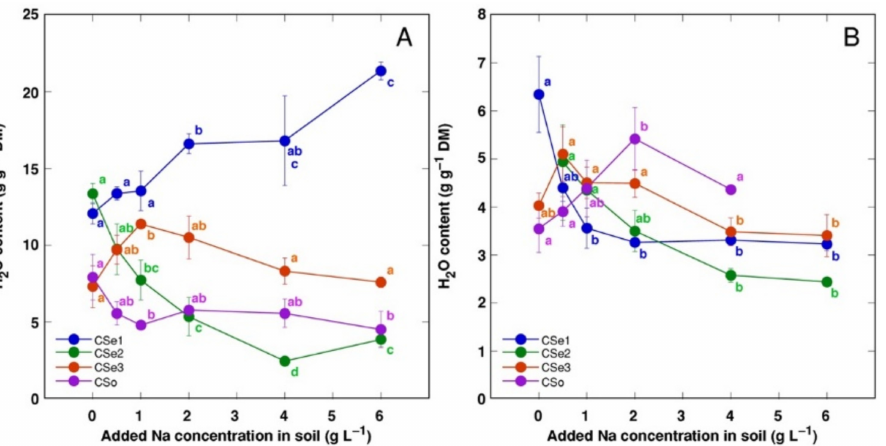
Figure 4. Effect of increasing soil salinity on water content in roots ( A ) and rhizomes ( B ) of Calystegia sepium accessions CSe1, CSe2, CSe3 and Calystegia soldanella (CSo). Na + was added in a form of NaCl. Data are means from five replicates for each concentration ± SE. Different letters of the respective color indicate statistically significant differences ( p < 0.05) between treatments for the respective model